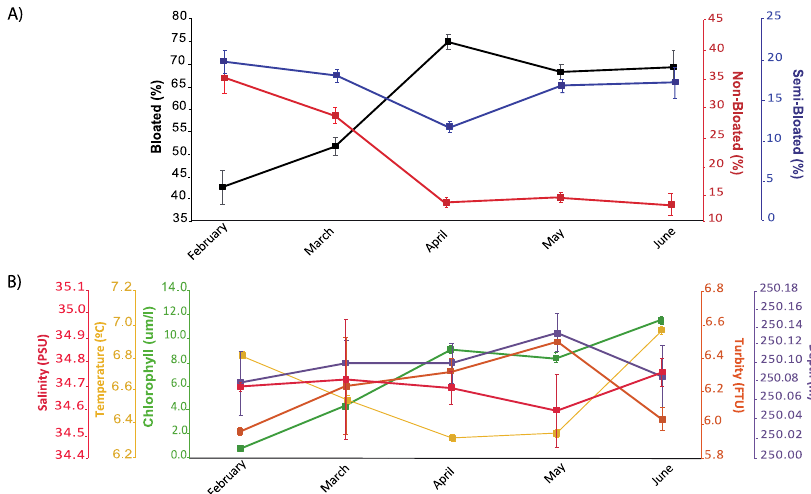
Figure 12. Seasonal pattern of variation in P. arborea polyps’ activity and concomitantly measured oceanographic variables. ( A ) Monthly average percentages of different polyp activity statuses. ( B ) Monthly averaged oceanographic variables. All data are presented with the standard deviation.